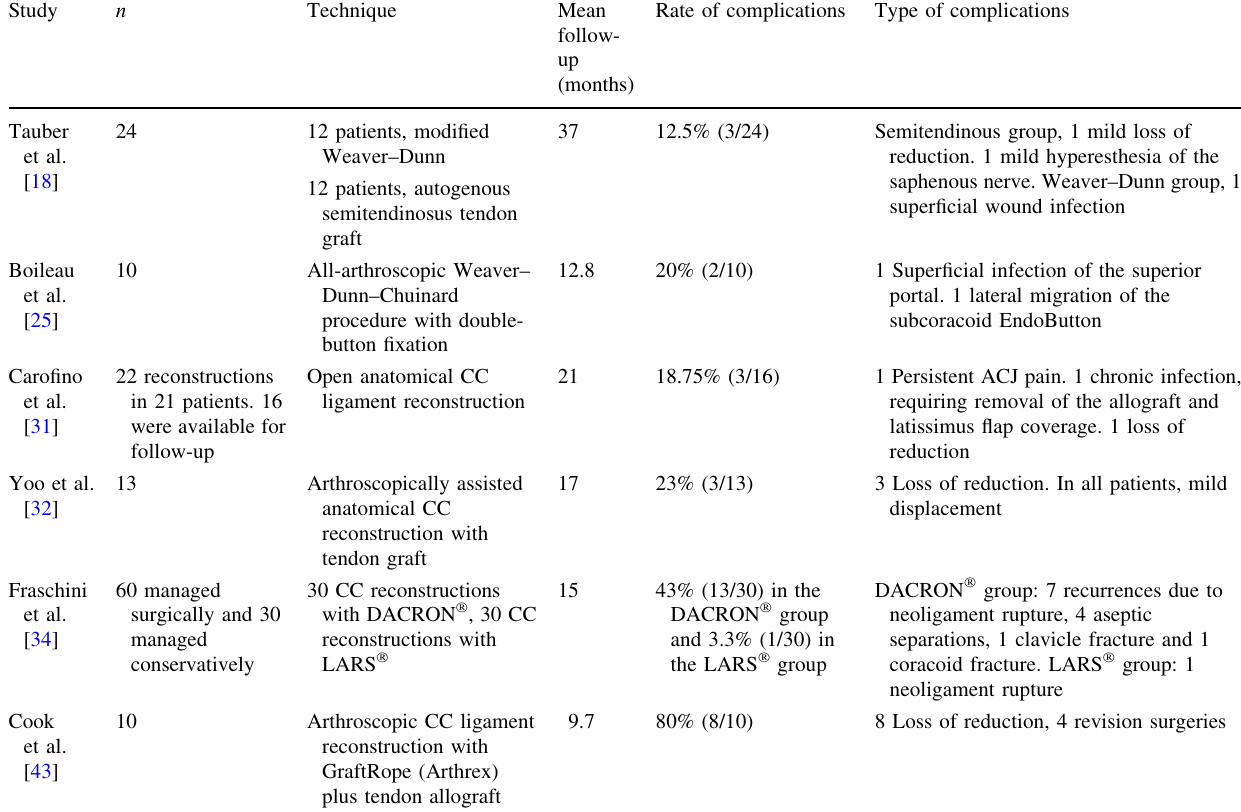
Table 3 Rate of complications according to different studies Study n Technique Mean